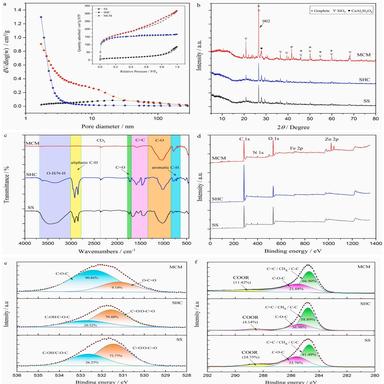
Structural properties of sewage sludge (SS), sludge hydrochar (SHC) and the prepared mesoporous carbon material (MCM). Pore size distribution (a), XRD (b), FTIR (c), XPS (d), XPS O 1s (e) and XPS C 1s (f) spectra.